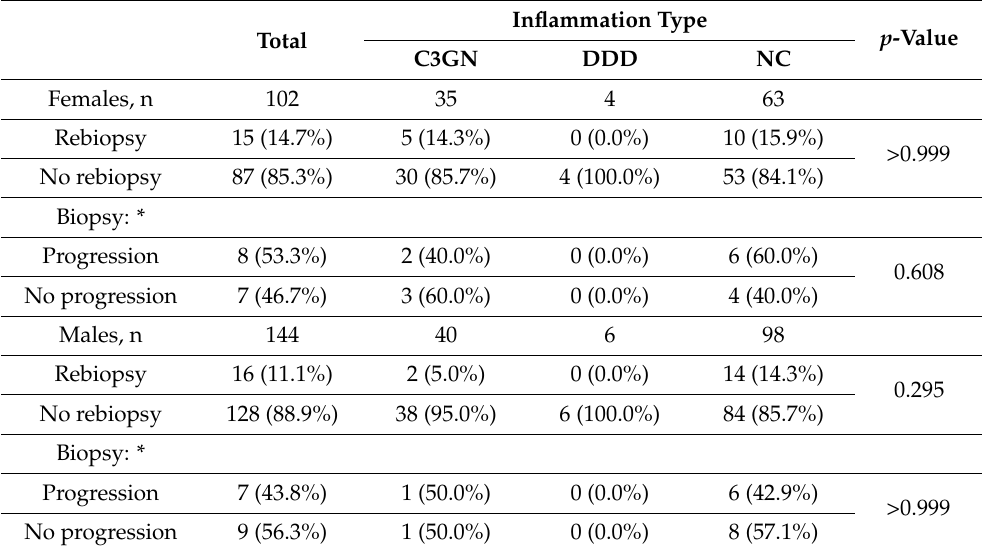
Table 3. Relationship between the type of inflammation, rebiopsy, and progression in adults. Inflammation Total